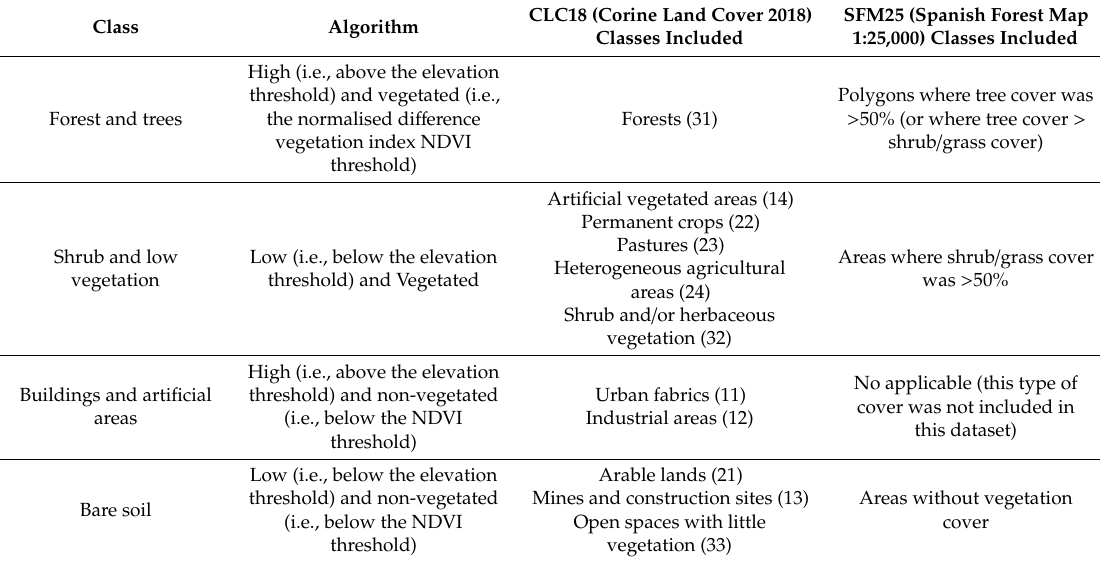
Table 1. Descriptions of the four types of land uses used for our developed algorithm and for the two reference maps used for validation: Corine Land Cover 2018 (CLC18) [46] and Spanish Forest Map 1:25,000 (MFE25) [47]. In the third column, the numbers in brackets show the code from CLC18